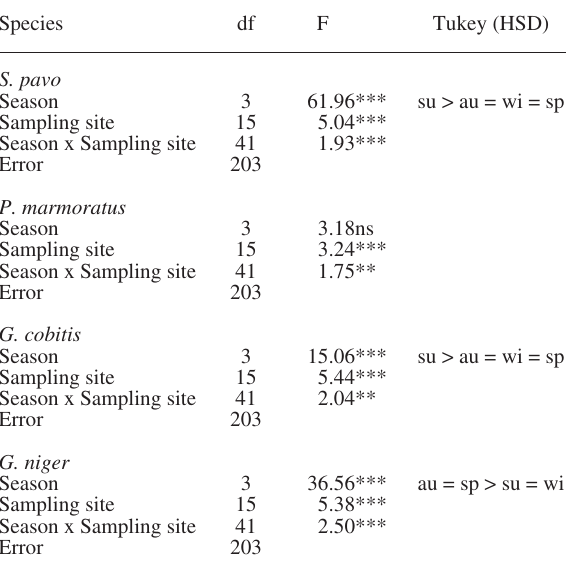
Table 4. − Results of two-way factorial analysis of variance per- formed on the fish standing stock [ln (g individuals/100 m 2 )] of